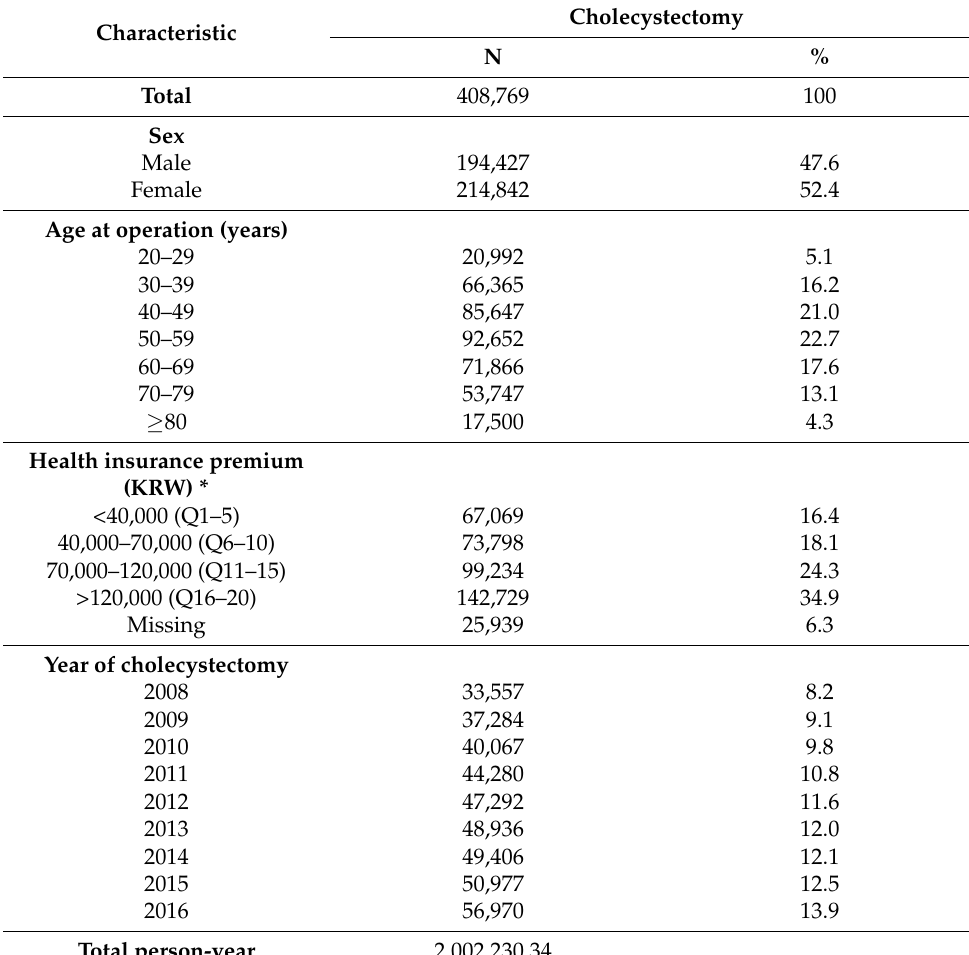
Table 1. Demographic characteristics of the cholecystectomy